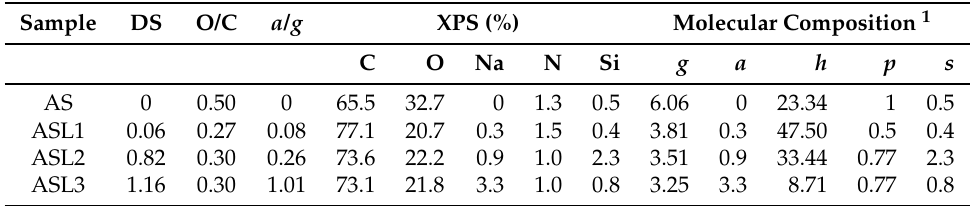
Table 1. DS results determined by NMR, XPS results and molecular composition of surfaces